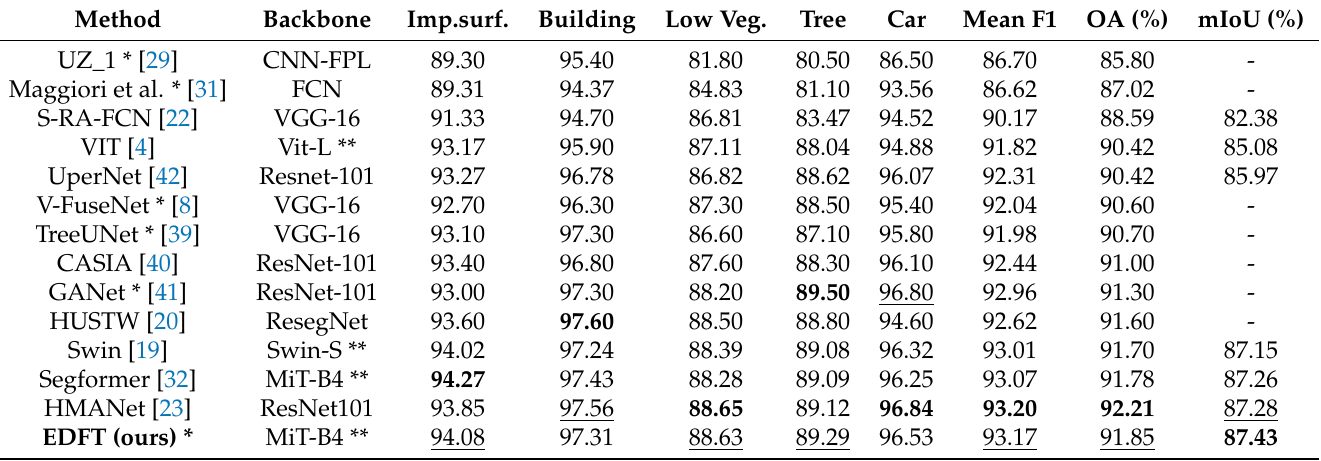
Table 2. Comparisons with state-of-the-art on Potsdam test set, where * represents the method employing DSM or NDSM, ** represents transformer backbone, and - represents missing data. The values in bold are the best and the values underlined are the second best.